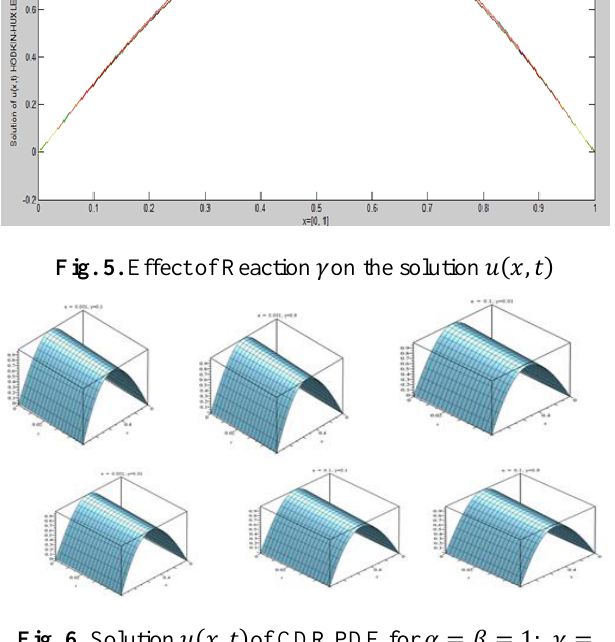
Fig. 6. Solution 𝑢(𝑥, 𝑡) of CDR PDE for 𝛼 = 𝛽 = 1; 𝛾 = 0.01,0.1,0.9 and 𝜀 = 0.001,0.1